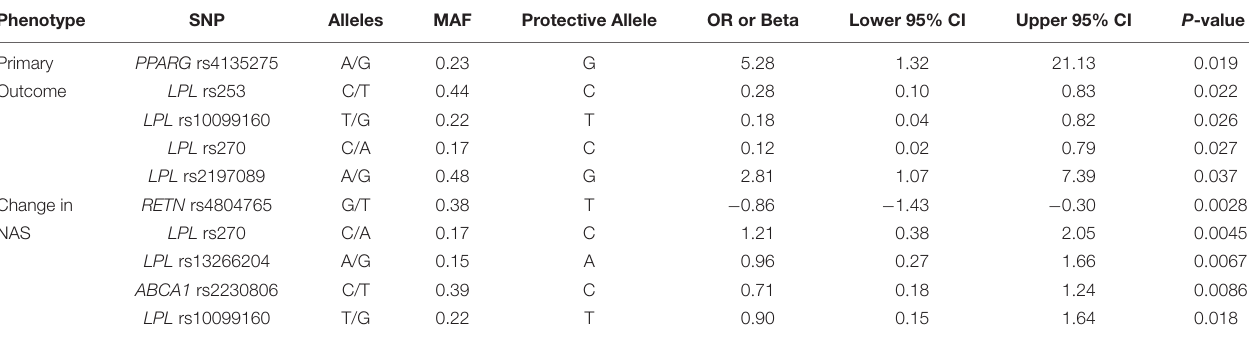
TABLE 3 | Single nucleotide polymorphism with a significant association with the primary outcome and/or change ≥ 2 in the NAFLD Activity Score ∗ .